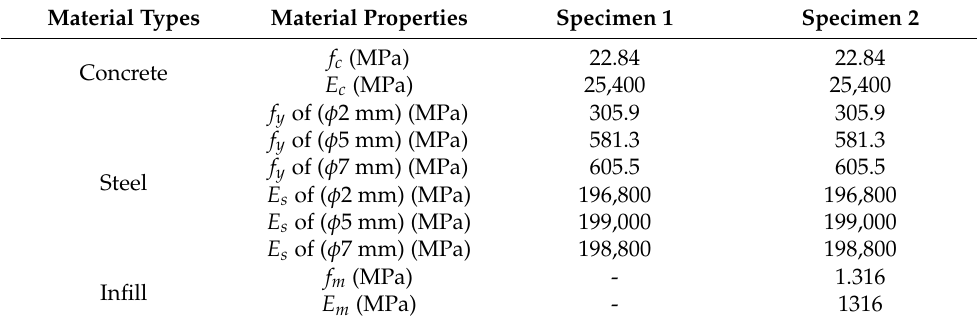
Table 3. Material properties of Van and Lau